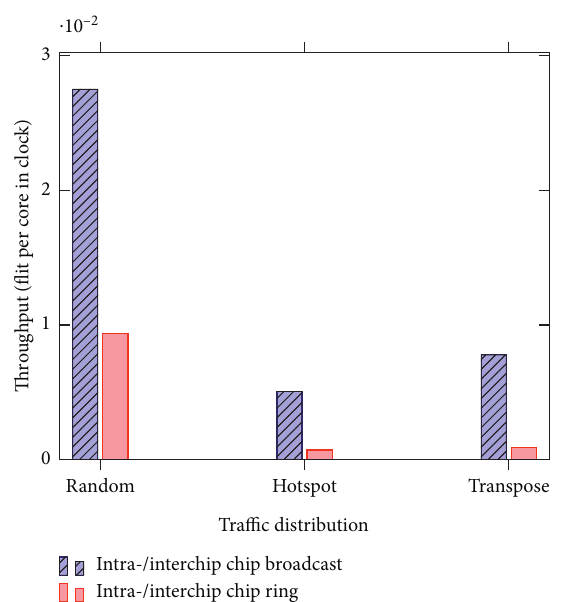
Figure 19: The power consumption of the proposed THz multichip system in comparison with the token-based mm-wave one with nonuniform traffic (PIR �